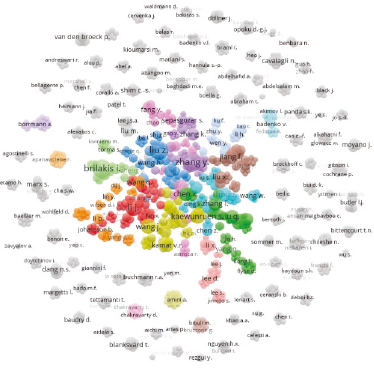
Figure 5: Network of coauthorship. Table 3: The coauthorship network’s general characteristics.